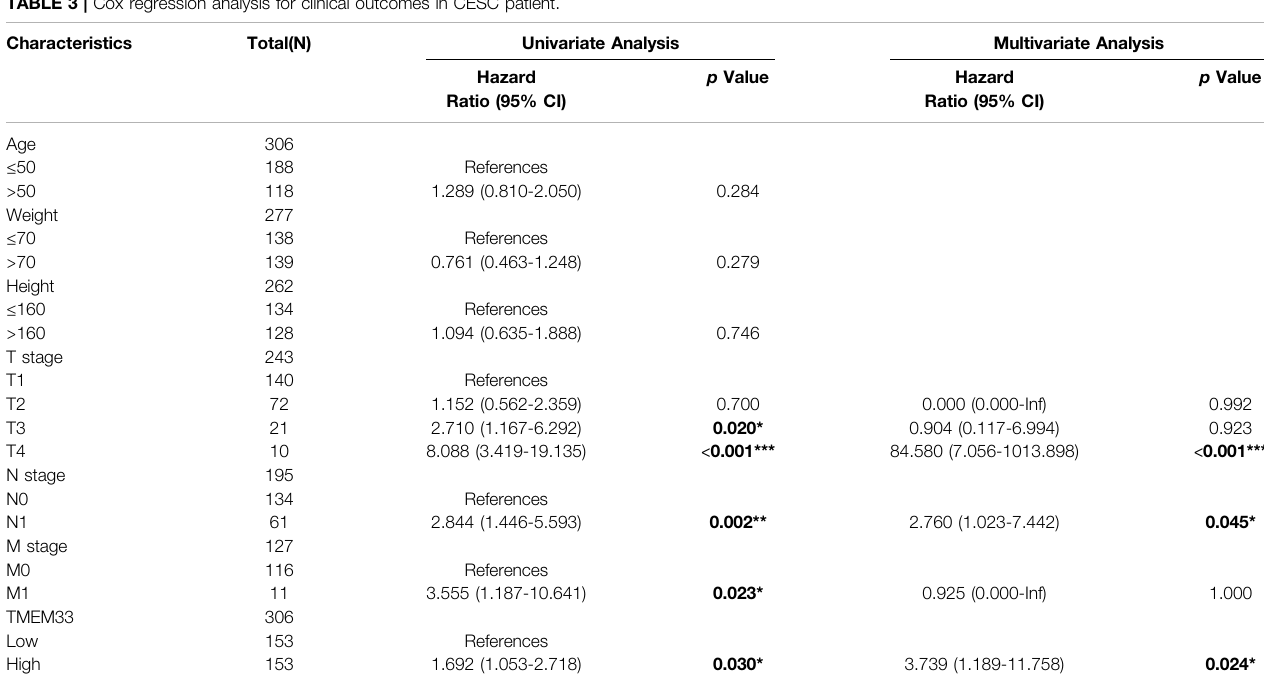
TABLE 3 | Cox regression analysis for clinical outcomes in CESC patient.